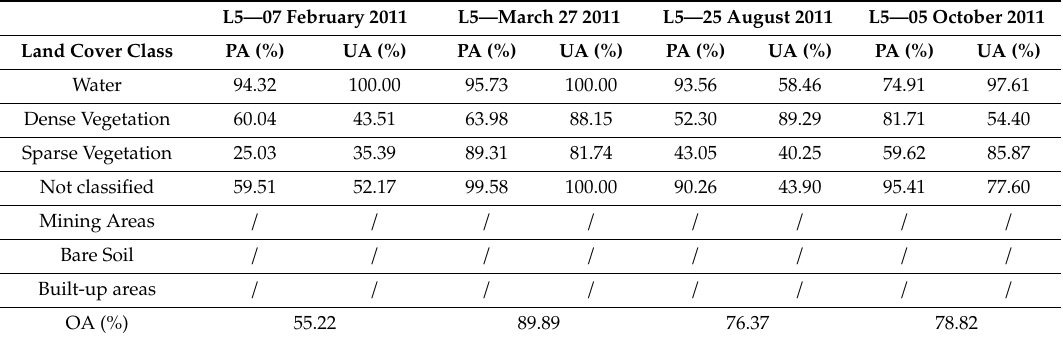
Table 8. OA, PA, and UA obtained through the application of Green Optimized Soil Adjusted Vegetation Index (GOSAVI) on the data acquired by Landsat 5 mission. UA, user’s accuracy; PA, producer’s accuracy; OA, overall accuracy.